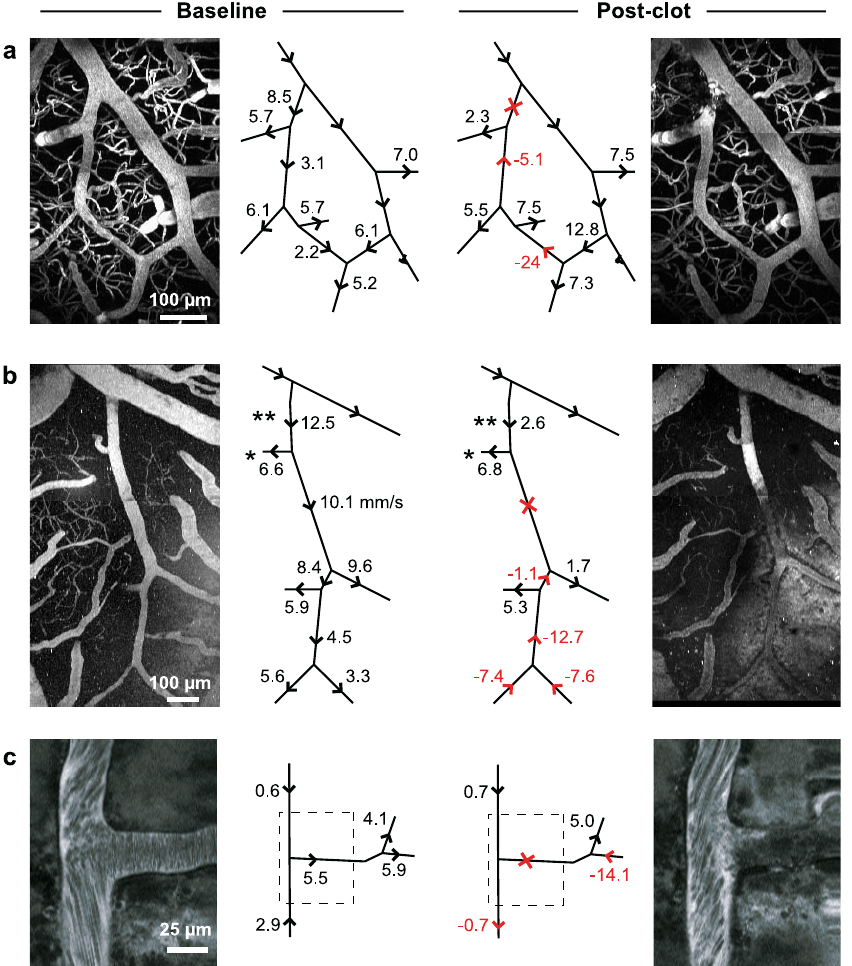
Figure 5. Examples of Flow Changes that Result from Localized Occlusion of a Cortical Surface Arteriole (A–C) On the left and right are TPLSM images taken at baseline and after photothrombotic clotting of an individual vessel, respectively. Left center and right center are diagrams of the surface vasculature with RBC speeds (in mm/s) and directions indicated. The red X indicates the location of the clot, and vessels whose flow direction has reversed are indicated with red arrows and labels. In the examples of panels (A) and (B) we show maximal projections of image stacks whereas the example in panel (C) shows single TPLSM planar images; the streaks evident in the vessels in these latter frames are due to RBC motion, and the dashed box in the diagrams represents the area shown in the images. DOI: 10.1371/journal.pbio.0040022.g005